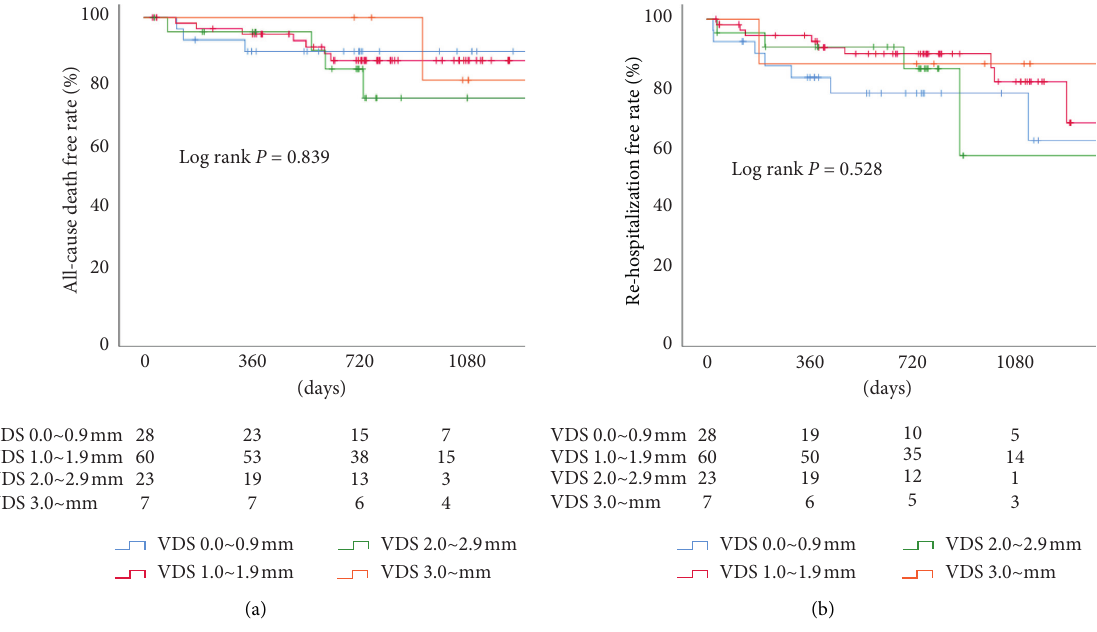
Figure 4: Kaplan-Meier curves of all-cause death free and rehospitalization free survival rates. There were no significant differences in the all-cause death free and rehospitalization free survival rates among various valve distortion scores (VDS).